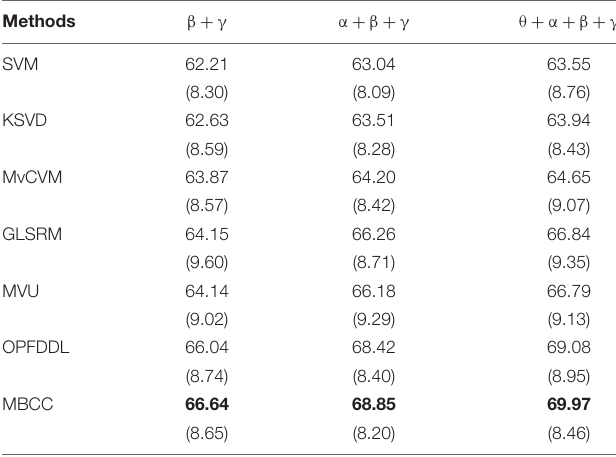
TABLE 5 | The accuracy (standard deviations) of all methods on the DEAP dataset in valence. Methods